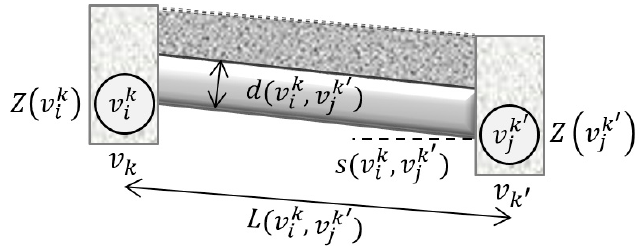
Figure 2. Hydraulic design representation of a single pipeline (diameter-slope) [9].